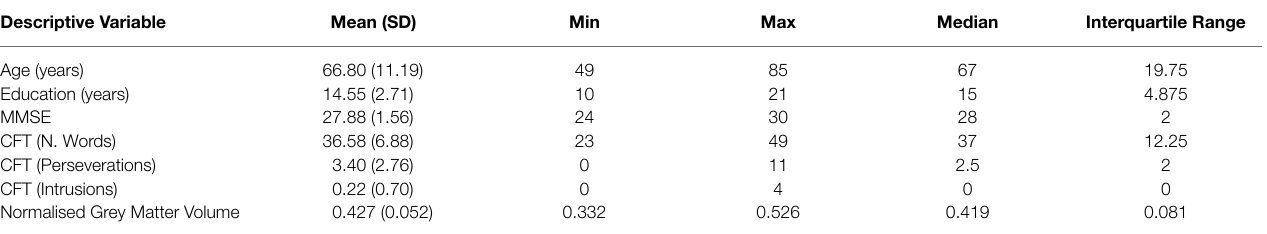
TABLE 1 | Demographic and neurocognitive characteristics of the